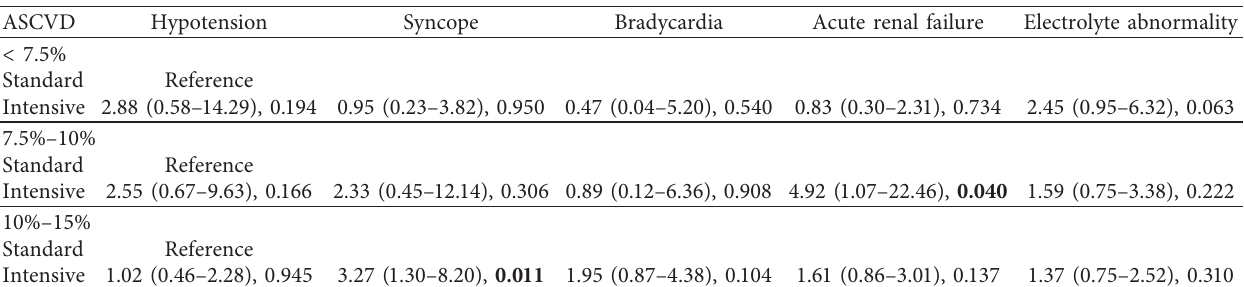
Table 4: Serious adverse events in the intensive- and standard-treatment